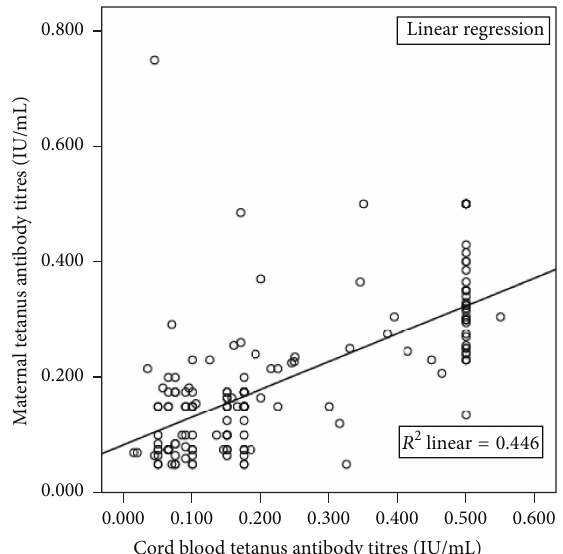
Figure 1: Pearson correlation between maternal and cord blood anti-tetanus antibody titres.